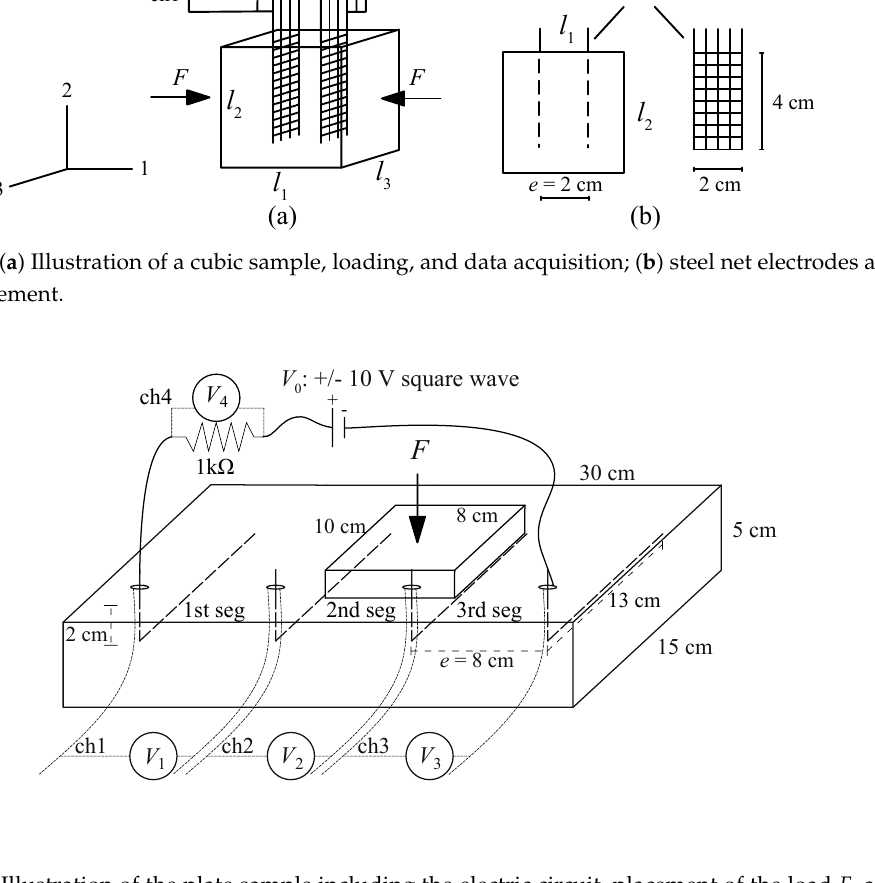
Figure 3. Illustration of the plate sample including the electric circuit, placement of the load F , and voltage acquisition channels (ch1 to